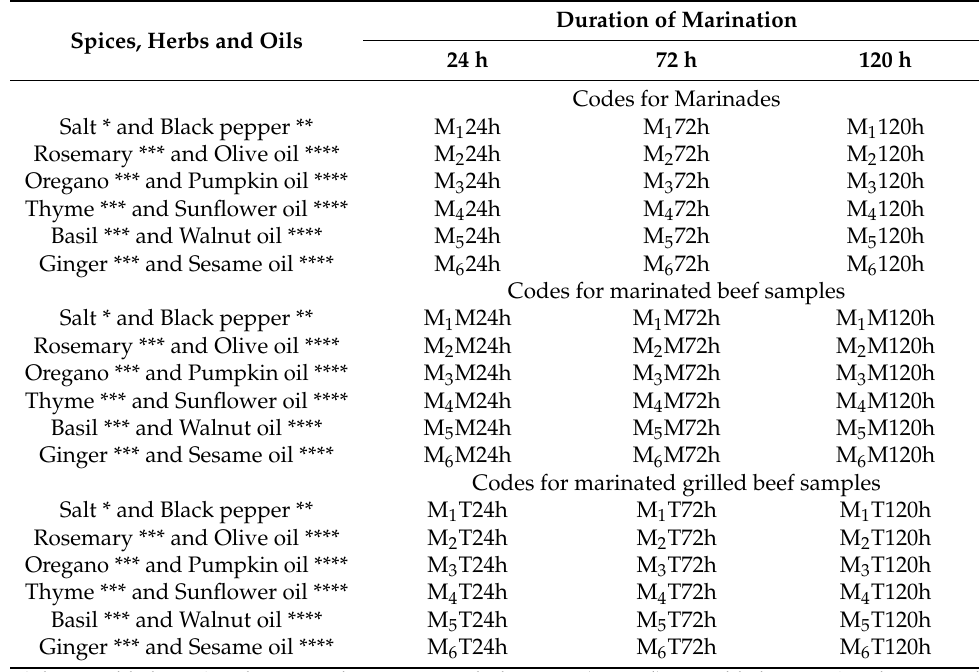
Table 1. The codification of samples used in the study.